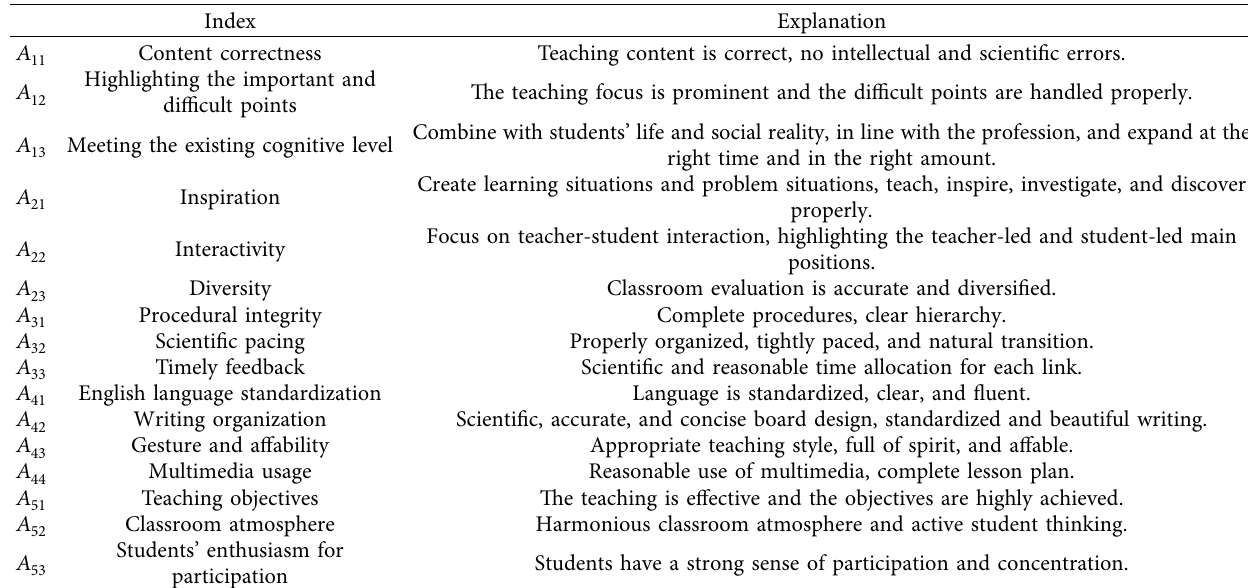
Table 1: Explanation of ECCU evaluation